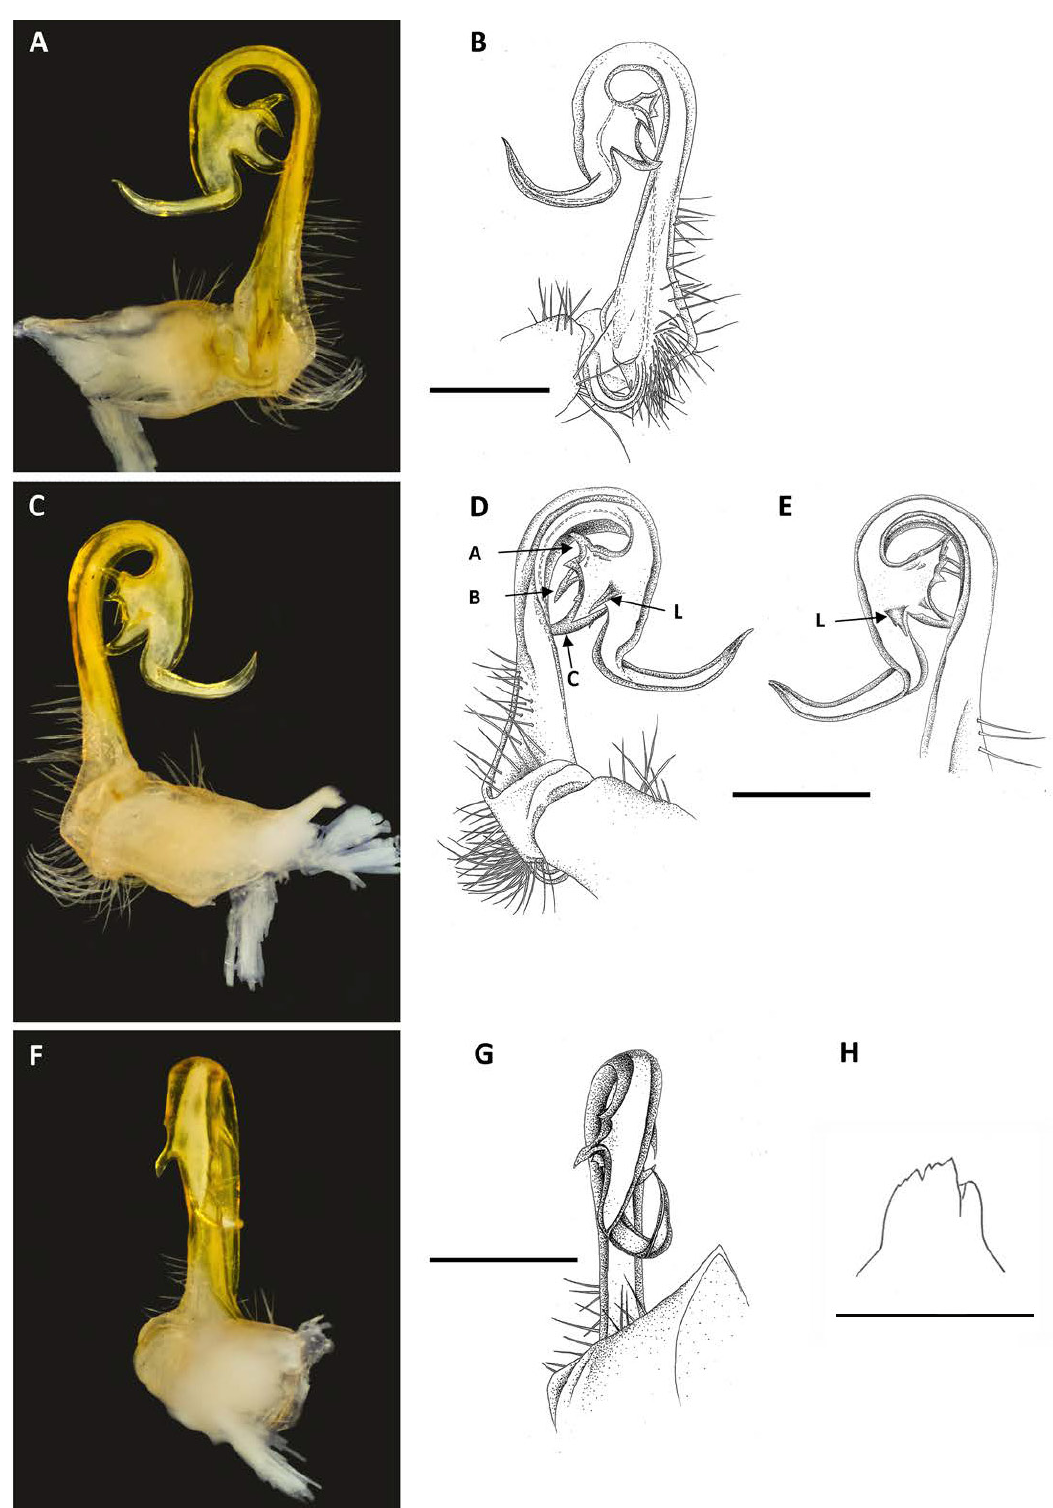
Fig. 21. Agrophogonus pusillokiellandi Olsen & Enghoff sp. nov., holotype, ♂ (NHMD 621683). A–D, F–G . Left gonopod. A–B. Mesal view. C–D. Lateral view. F–G. Dorsal view. E . Right gonopod, lateral view. H . Sternal process on ring 6. Abbreviations: A = process A; B = process B; C = process C; L = process L. Scale bars: 0.5